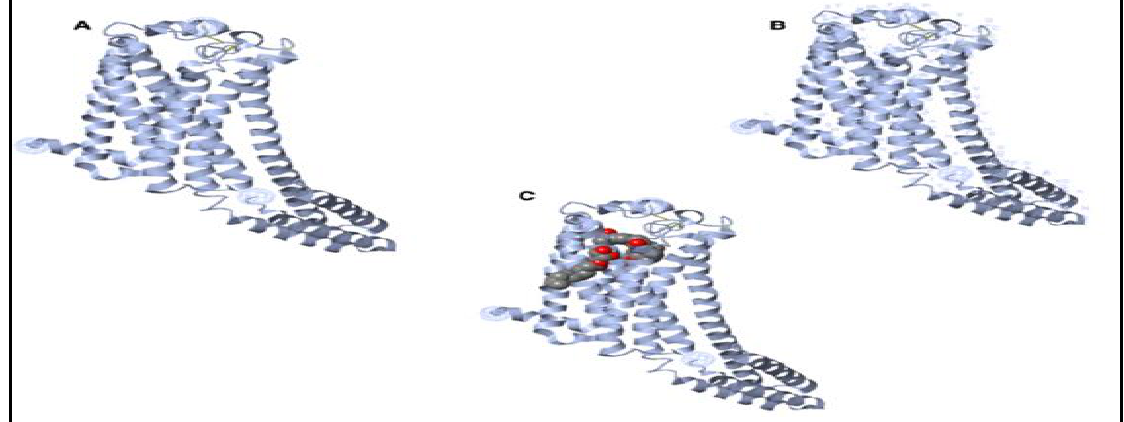
Figure 2. The crystal structure of the human Lysophosphatidic acid receptor 1 (A) illustrating the 7 transmembrane nature of these receptors, (B) with its constituents amino acids represented by their international one letter codes A-Alanine R-Arginine N-Asparagine D-Aspartic acid C-Cysteine E-Glutamic acid Q-Glutamine G-Glycine H-Histidine I-Isoleucine L-Leucine K-Lysine M-Methionine F-Phenylalanine P-Proline S-Serine T-Threonine W-Tryptophan Y-Tyrosine and V-Valine (C) The receptor being occupied by a ligand, shown as balls, called ONO-3080573. Baskets in the diagram indicate missing amino acids. The structure was constructed using the visualisation software given in reference